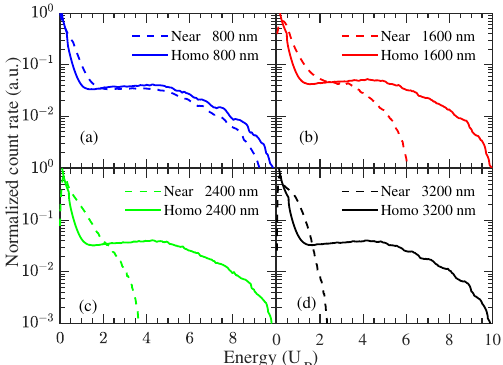
Figure 4. (color online) Normalized energy-resolved photoelectron spectra comparison between the near-field (dot curve) and the homogeneous field (solid curve) cases, for various wavelengths using the CTMC method. For convenience, the electron energy is set in terms of U p . The homogeneous field refers to the one that only contains the field enhancement, but not the field decay. All the spectra are averaged over different CEPs and the focal spot. ( a ) simulated spectra for a laser wavelength λ = 800nm, ( b ) λ = 1600nm, ( c ) λ = 2400nm and ( d ) λ = 3200nm. The rest of the laser parameters are the same as those in Figure